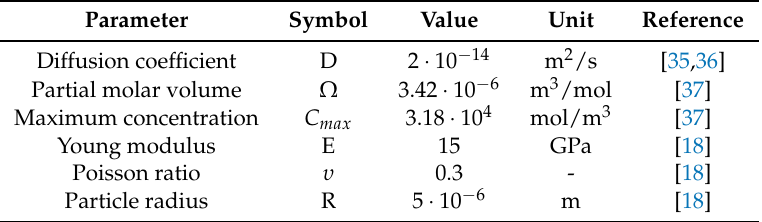
Table 1. Graphite properties (anode).